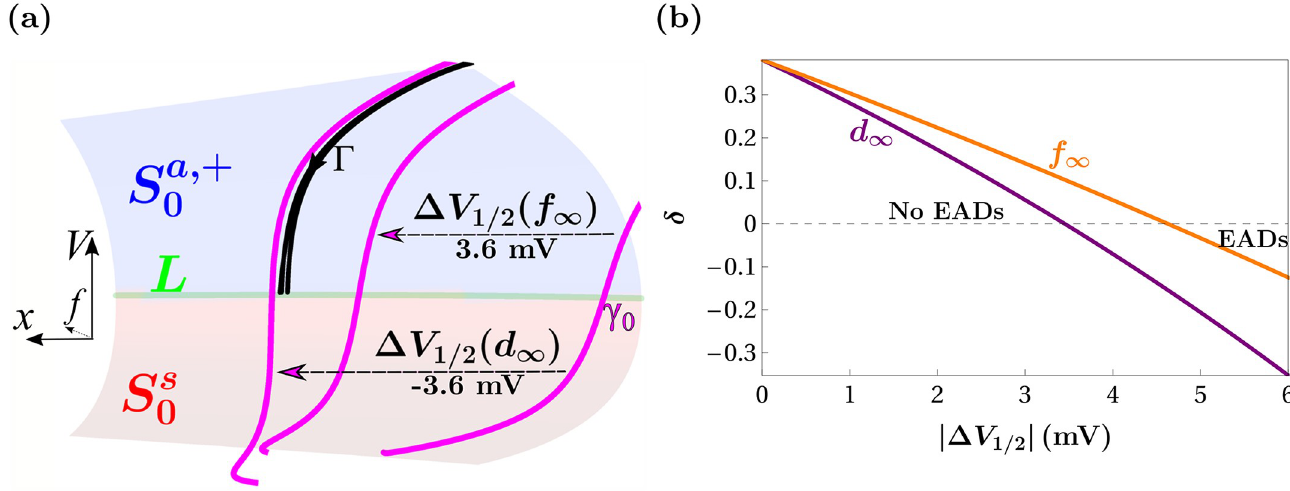
Fig 8. Left shifts in the Ca 2+ channel activation curve move the primary maximal canard further than equal right shifts in the inactivation curve. ( a ) Three primary maximal canards corresponding to default ( γ 0 , right, magenta), right-shifted f 1 ( V ) (middle, magenta), and left-shifted d 1 ( V ) (left, magenta) conditions are superimposed on the critical manifold of the default parameter set. Also shown is a portion of the trajectory during the plateau phase of an action potential ( Γ , black) for each condition. These three trajectory segments are almost identical, but the one corresponding to left-shifted d 1 ( V ) enters the funnel and will subsequently exhibit EADs. ( b ) The distance, δ , between Γ and γ 0 declines faster with left shifts in d 1 ( V ) than with right shifts in f 1 ( V ).